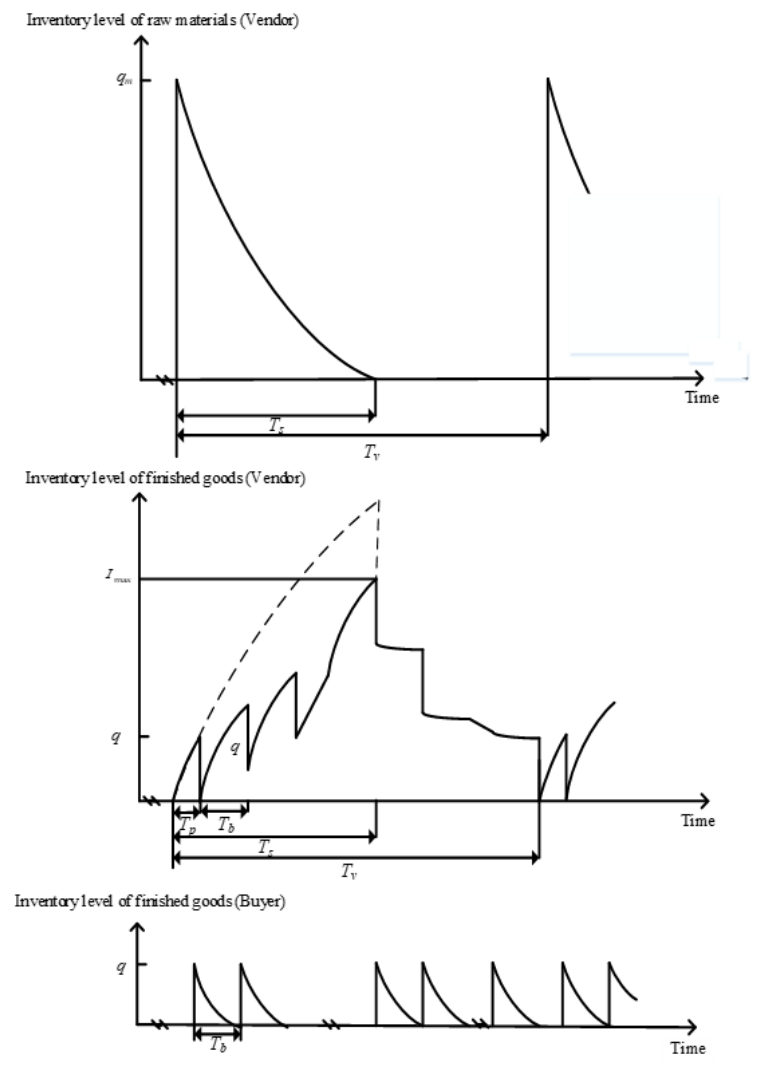
Figure 1. The production–inventory system for the buyer and vendor. Substituting t = 0 into Equation (2), and from the fact q = I ( 0 ) , it can